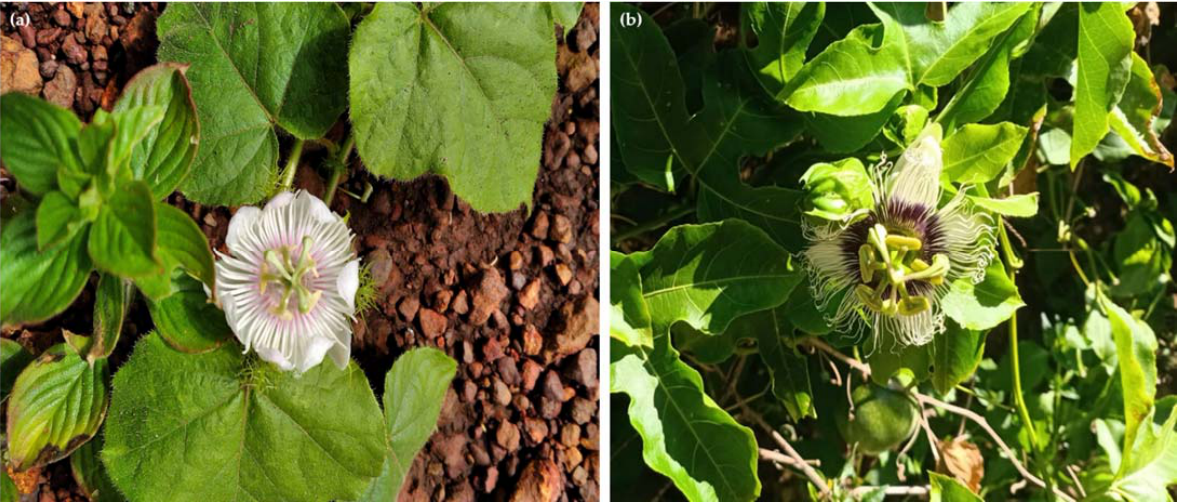
Figure 3. Morphological differences between a wild and a cultivated species of Passiflora L. ( a ) P. foetida and ( b ) P. edulis respectively.